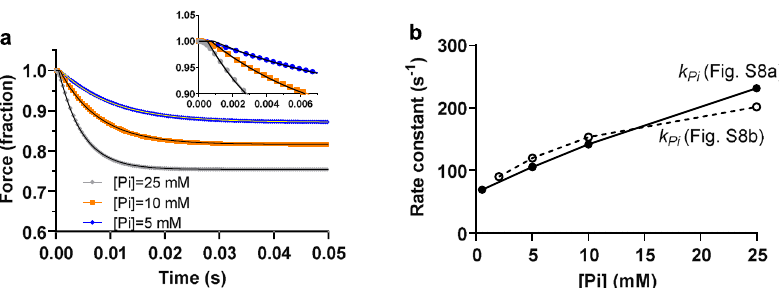
Fig.5|Modelingofkeyfeaturesoftheisometrictensionchangesinresponseto suddenchangesinthePi-concentration(Pi-transients).a Simulatedtensiontime course(normalized)forthemodelinSupplementaryFig.8auponasuddenincrease in[Pi]from0.1mMtotheconcentrationindicated.Curvedblacklinesrepresent fi ts tothedataofasingleexponentialfunctionwithatimelag( Δ t ).Inset:theearlyphase of tension change and time lag illustrated on an expanded time base. b Model simulations of the rate constant of tension change ( k Pi ) after a sudden jump in Pi- concentrationvsthe fi nal[Pi]forthemodelsinSupplementaryFig.8a,b.Theseare simpli fi ed versions of the model in Fig. 4 (useful for isometric contraction; cf. gray stars and triangles in Fig. 4c) with the bene fi t that simulations of Pi-transients are